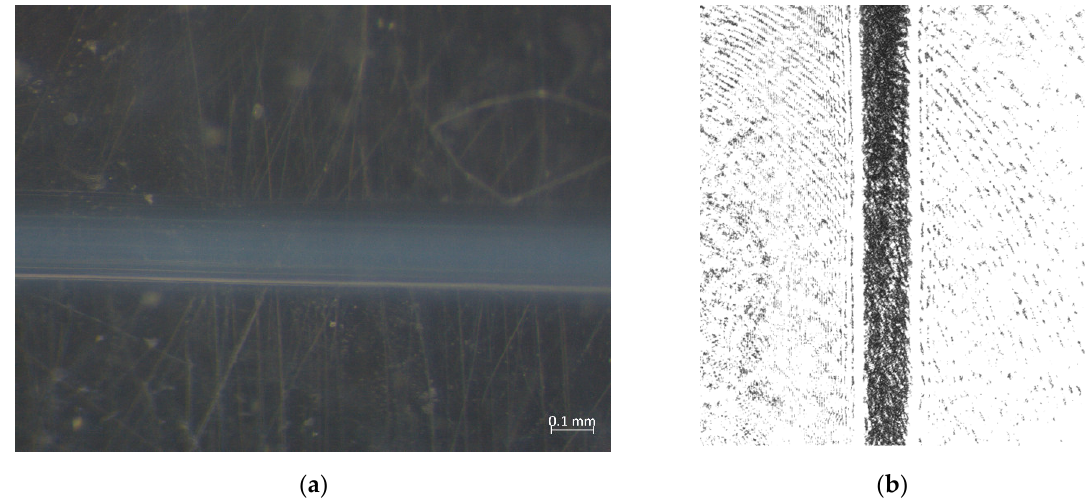
Figure 15. ( a ) Photograph obtained from an optical microscope of a crack manually generated in a piece of plastic; ( b ) diffraction pattern on the CCD of a crack in a piece of plastic.